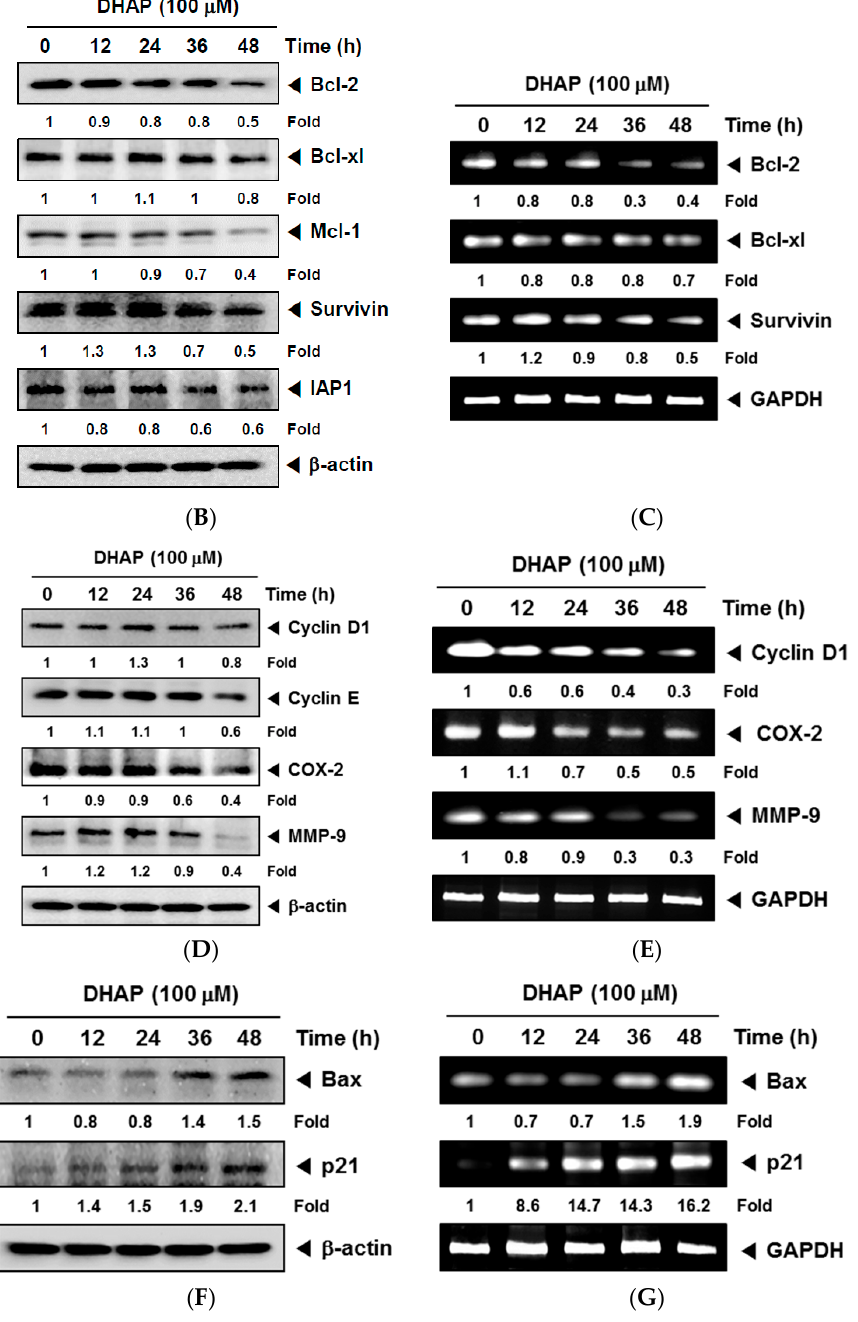
Figure 1. Effect of DHAP on anti-apoptotic and pro-apoptotic gene expression in U266 cells. ( A ) The chemical structure of 2,5-Dihydroxyacetophenone (DHAP). U266 cells were treated with 100 μ M of DHAP for the time periods stated; ( B ) Bcl-xl, Bcl-2, Survivin, Mcl-1, and IAP1 protein levels were determined via Western blot analysis; ( C ) The gene expression levels of Bcl-xl , Bcl-2 , and Survivin were determined by RT-PCR; ( D ) Cyclin D1, Cyclin E, COX-2, and MMP-9 protein levels were determined via Western blot analysis; ( E ) Cyclin D1 , COX-2 and MMP-9 gene expression levels were determined by RT-PCR; ( F ) The protein levels of Bax and p21 were determined via Western blot analysis; ( G ) The gene expression levels of Bax and p21 were determined by RT-PCR. The immunoblot was stripped and reprobed for β -actin to ensure equal protein loading. GAPDH mRNA expression was used as an internal control for normalization purposes. Densitometric quantitation in fold change of each band has been indicated below the gel. The results shown are representative of the three independent experiments.